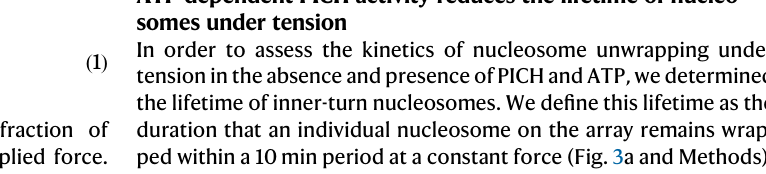
Fig.1|PICHcanbindtoexposeddsDNAonnucleosome-arrayconstructsunder tension. a Representative fl uorescenceimagesand schematic representations of a nucleosome-array construct with Anti-H3-Alexa647 antibody labelled histones, tethered between two optically-trapped beads, after 1-minute incubation with PICH-eGFP and ATP (at 10pN). The Anti-H3-Alexa647 and PICH-eGFP signals and a composite of the two are displayed in ( i ), ( ii ) and ( iii ), respectively. The dashed white boxeshighlight the regioncontaining the nucleosome-array construct.Scale bars correspond to 2 µ m. Similar PICH and histone distributions were observed on >10 independent nucleosome-array constructs. b Top: Schematic representations ofPICHbindingtoanucleosomearrayat~1pN( i )andat~3pN( ii ).TheDNA,histone octamers and PICH are depicted in black, red and green, respectively. Middle: